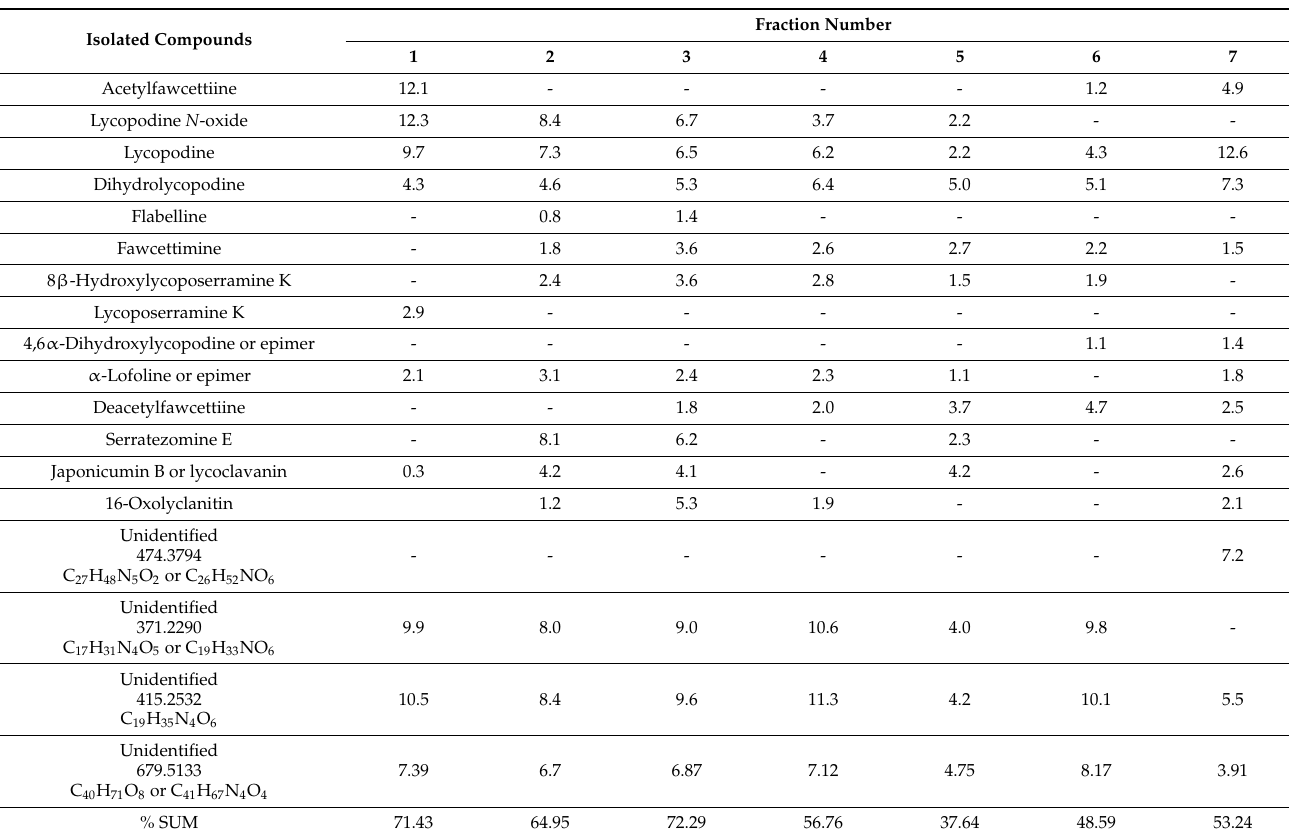
Table 9. Results of alkaloids identified via HPLC/ESI-QTOF-MS present in fractions 1–7 obtained from experiment 3 via VLC using silanized silica gel as a sorbent from L. clavatum extract. Isolated Compounds